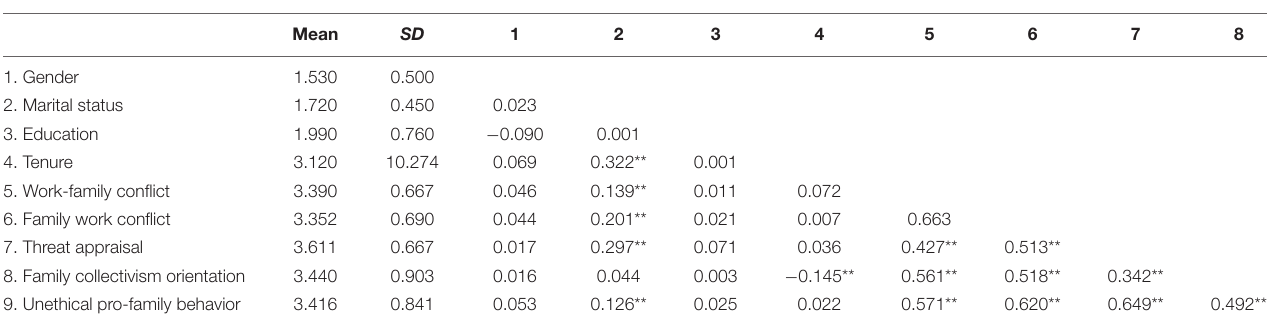
TABLE 2 | Means, standard deviations, and correlation coefficients of